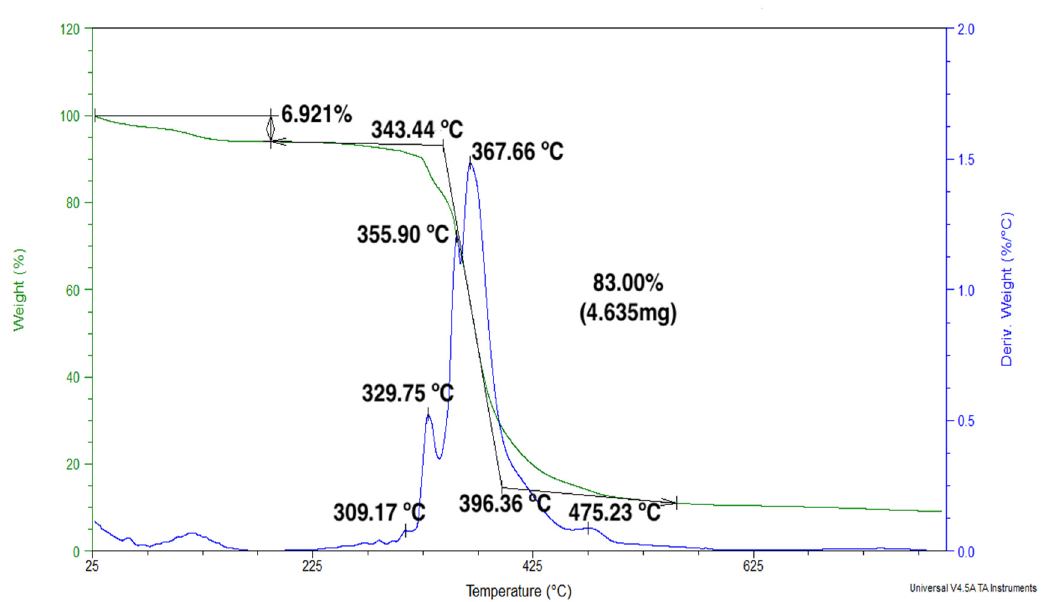
Figure 7. TGA and first derivate (DTG) curves of 30 vol% ramie fabric GO-incorporated epoxy composite.